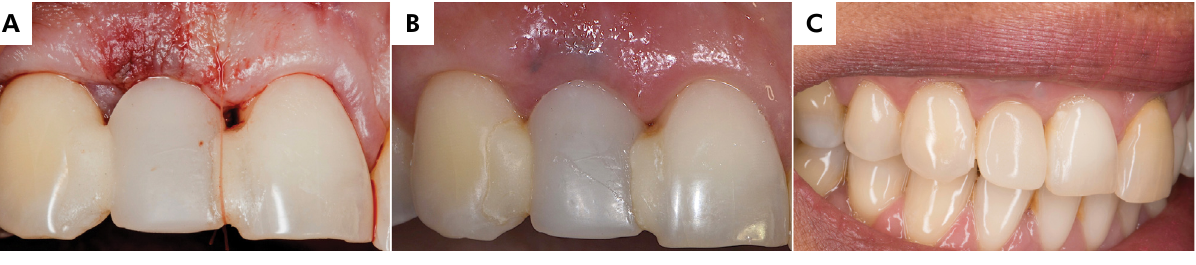
Figure 10. The papillae and flap were coronally advanced with sutures (a). Clinical aspect one month (b) after the surgery and one year after performing an implant